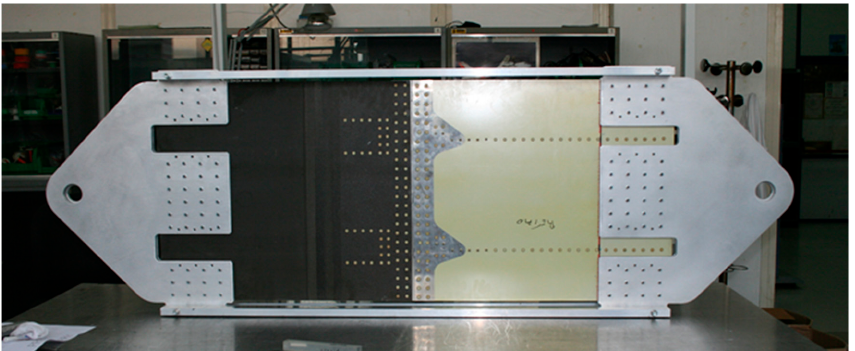
Figure 6. Hybrid panel (back side) including clamps. Appl. Sci. 2020 , 10 , x FOR PEER REVIEW